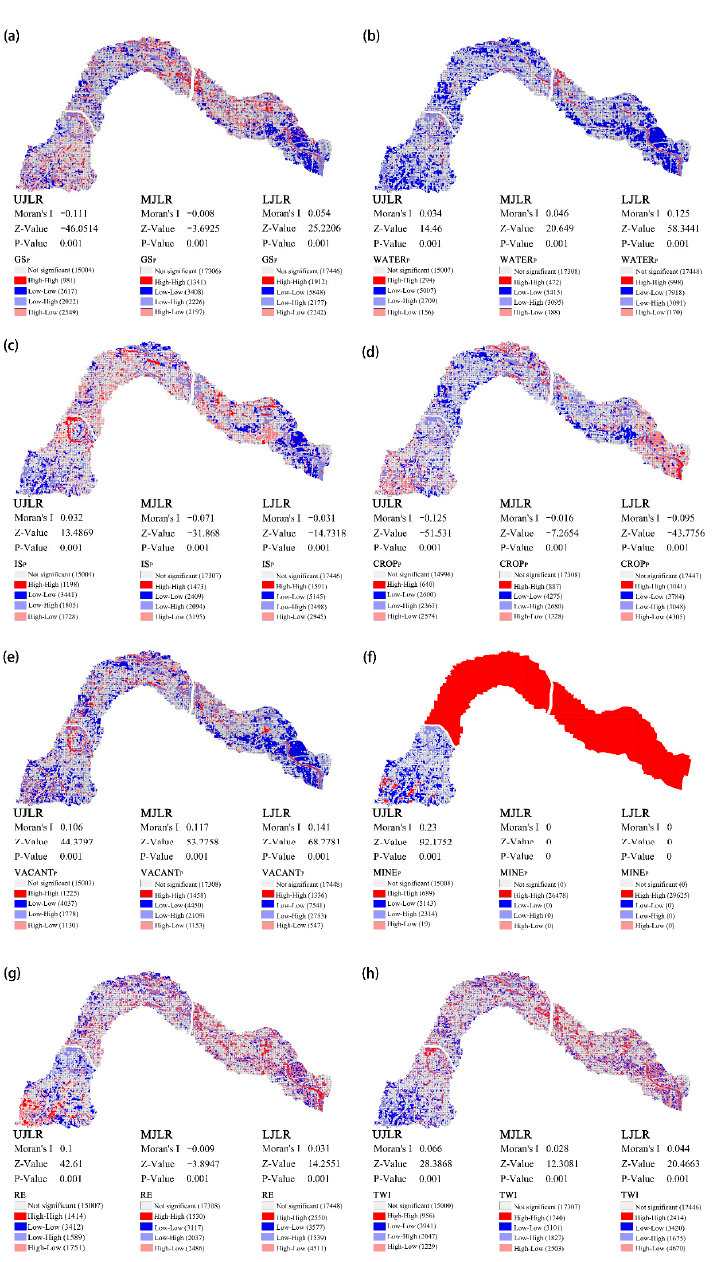
Figure 7. Cluster maps of local bivariate Moran’ I between landscape characteristics indexes of riverfront and flood inundation intensity. ( a – h ) UJLR, MJRL,